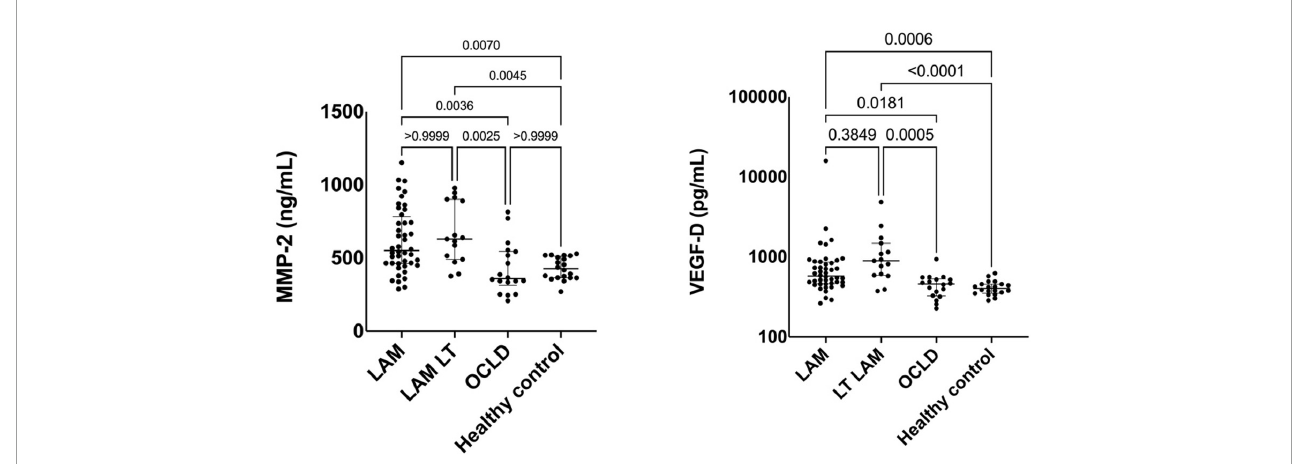
FIGURE3 Comparison of serum metalloproteinase-2 (MMP-2) and vascular endothelial growth factor-D (VEGF-D) levels between lymphangioleiomyomatosis (LAM) patients, LAM lung transplantation (LT) patients, other cystic lung diseases (OCLD), and healthy controls. Solid lines indicate median and interquartile range